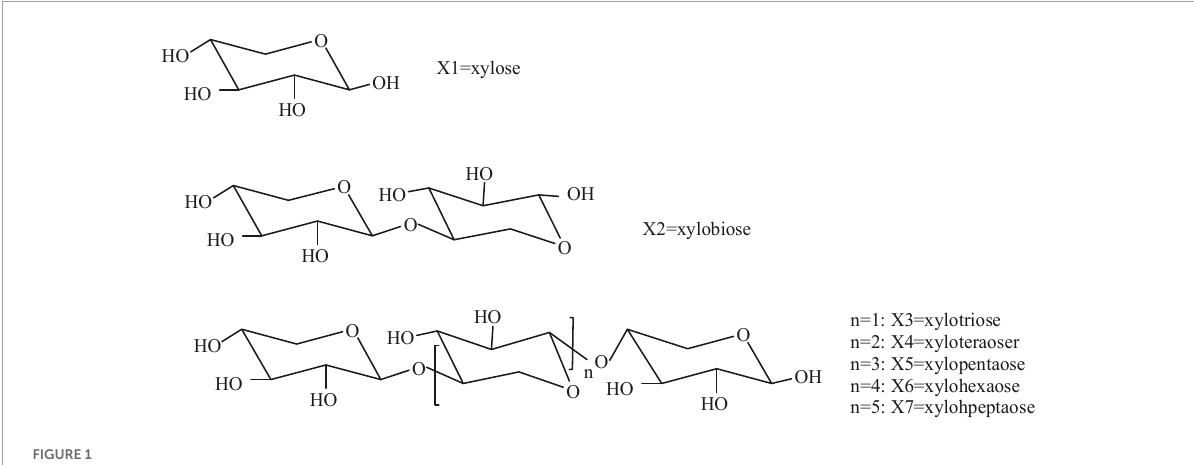
FIGURE1 The schematic structure of xylose and